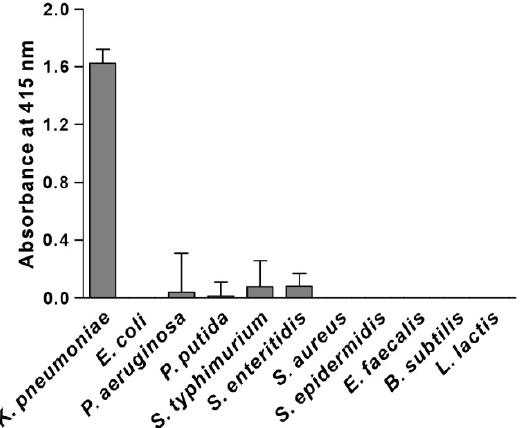
Figure 2. Specificity and selectivity of KP peptide binding to K. pneumoniae. The binding activity of KP peptide to different bacterial cells was determined by peptide-binding ELISA. Microtiter plates were coated with bacterial cells and incubated with the biotinylated KP peptide. The bound peptide was detected by HRP-conjugated streptavidin and the substrate ABTS. The data are presented as the mean ± SD of three independent experiments performed in triplicate.